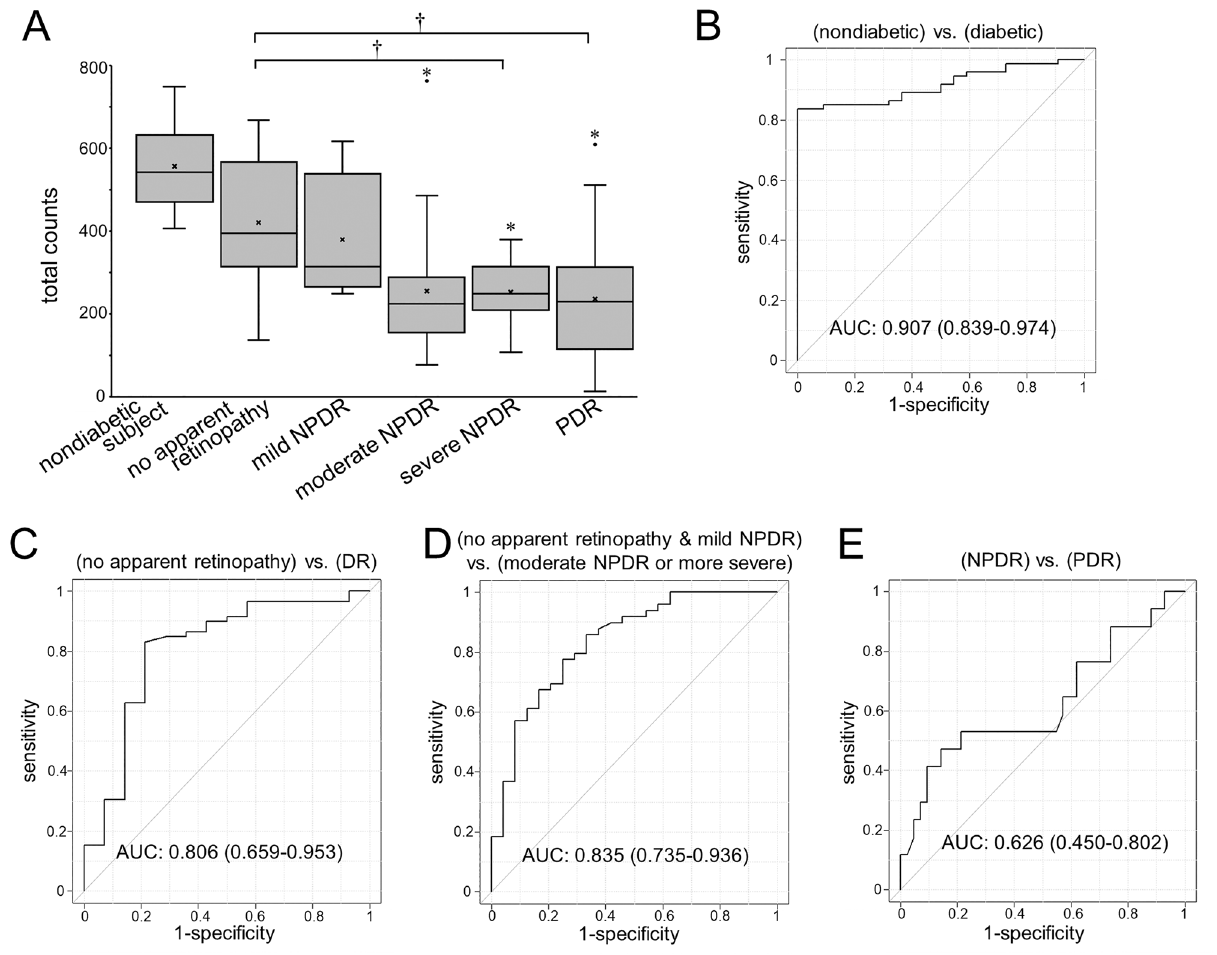
Figure 3. Total numbers of intercapillary spaces in each DR severity grade. ( A ) The total numbers of intercapillary spaces decrease according to DR severity; some eyes with no apparent retinopathy have fewer spaces than nondiabetic eyes. * P < 0.001 versus nondiabetic eyes. † P < 0.05 versus no apparent retinopathy. ( B ) The ROC curve reveals the significant power of the total intercapillary space counts to discriminate between the eyes of diabetic and nondiabetic patients. The ROC curves to discriminate DR from no apparent retinopathy ( C ) and referable DR from mild NPDR or no apparent retinopathy ( D ) also show fair power. However, the AUC for the discrimination of PDR from NPDR is not significant ( E